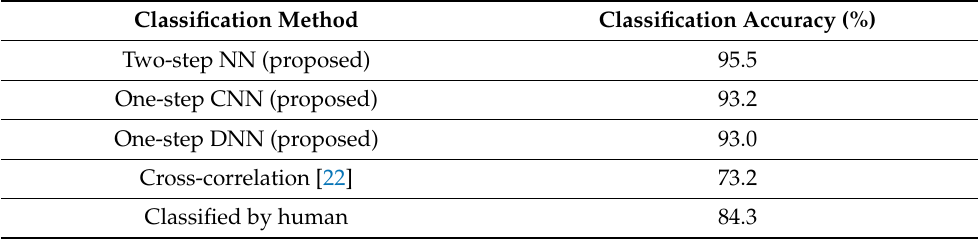
Table 7. Comparison of Classification Accuracy .